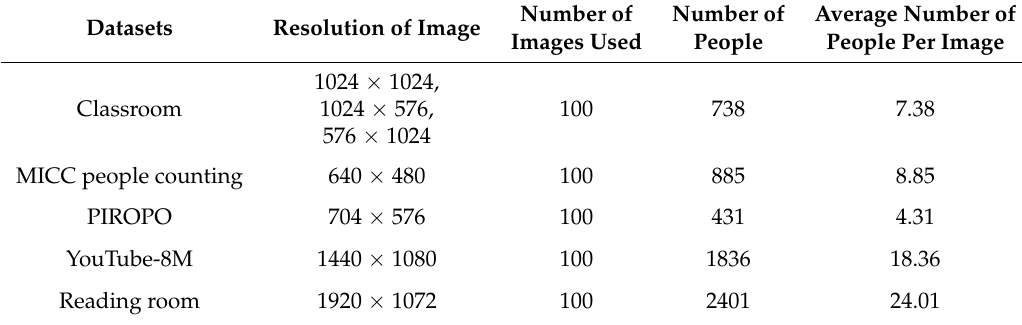
Table 1. Testing dataset description.